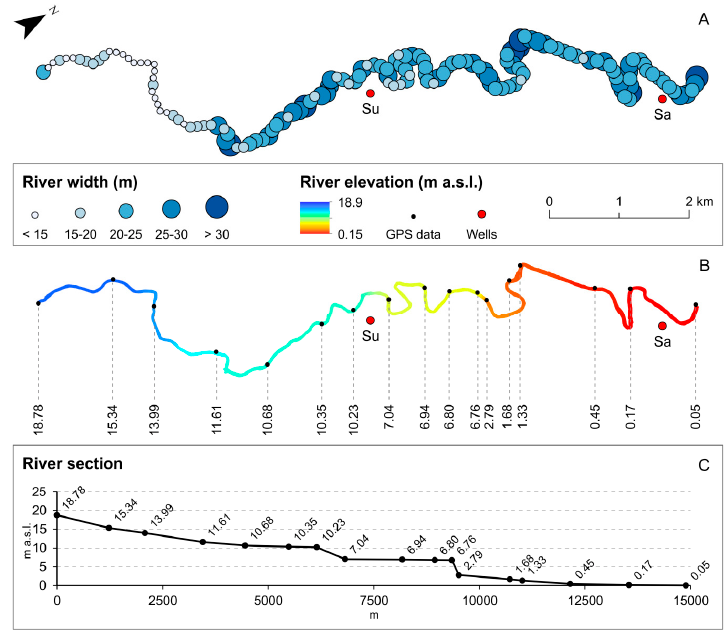
Figure 3. Morphologic and hydraulic characteristics of the river profile assessed in this study: ( A ) distribution of the river width; ( B ) plan view of the elevation of the river water profile (GPS survey, April 2015); and ( C ) elevation profile of the river water head.